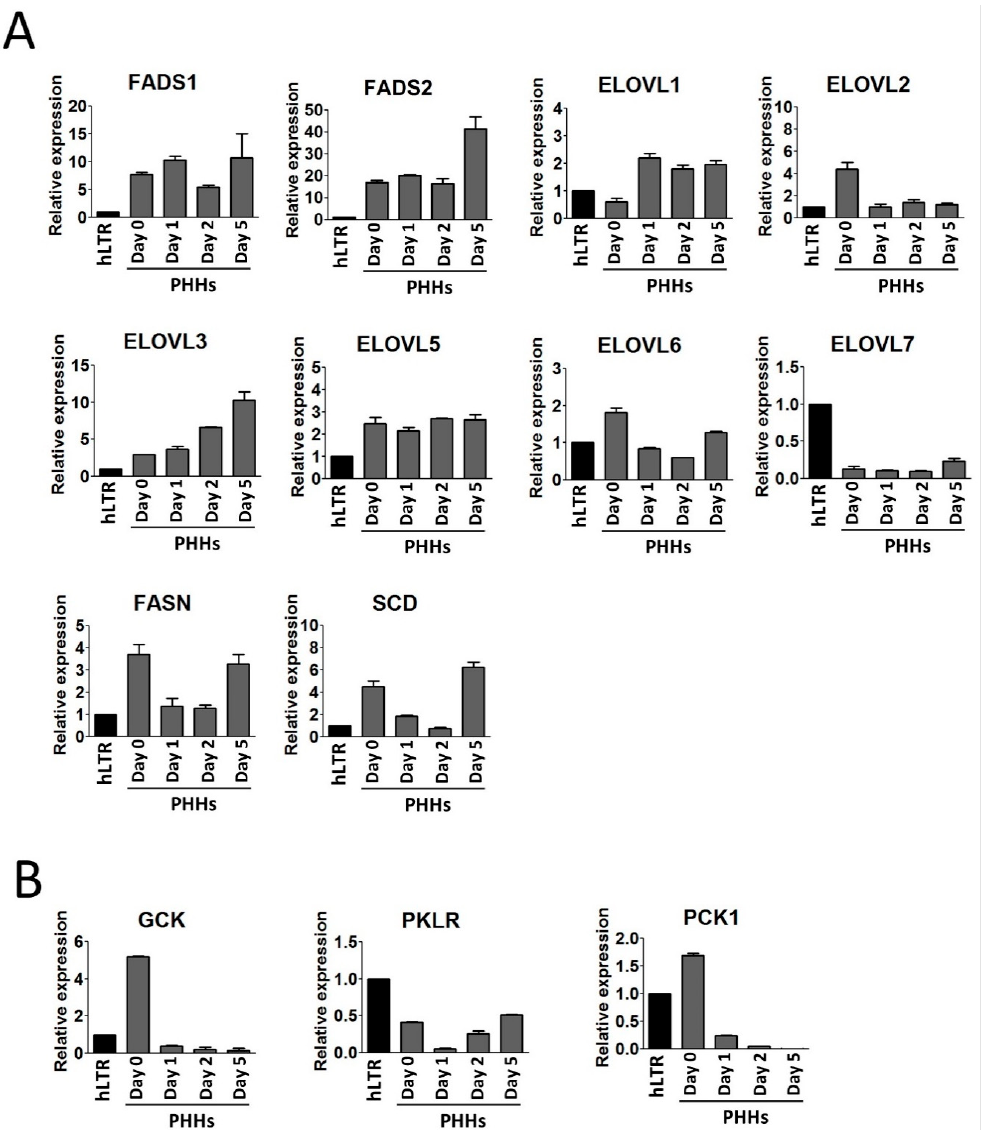
Figure 5. Real-time qPCR analysis of genes involved in the metabolism of fatty acids (FAs). ( A ) and glucose homeostasis ( B ) studied in dedi ff erentiating PHHs. The expression of ( A ) FASN , SCD , FADS1 , FADS2 , ELOVL1 , ELOVL2 , ELOVL3 , ELOVL5 , ELOVL6 , and ELOVL7 and ( B ) GCK , PKLR , and PCK1 at time points day 0, 1, 2, and 5. The expression of each gene was normalized to both GAPDH and B2M as endogenous controls. The values are presented relative to the hLTR sample. Each sample was run in technical triplicate and bars represent mean ± SD of three biological